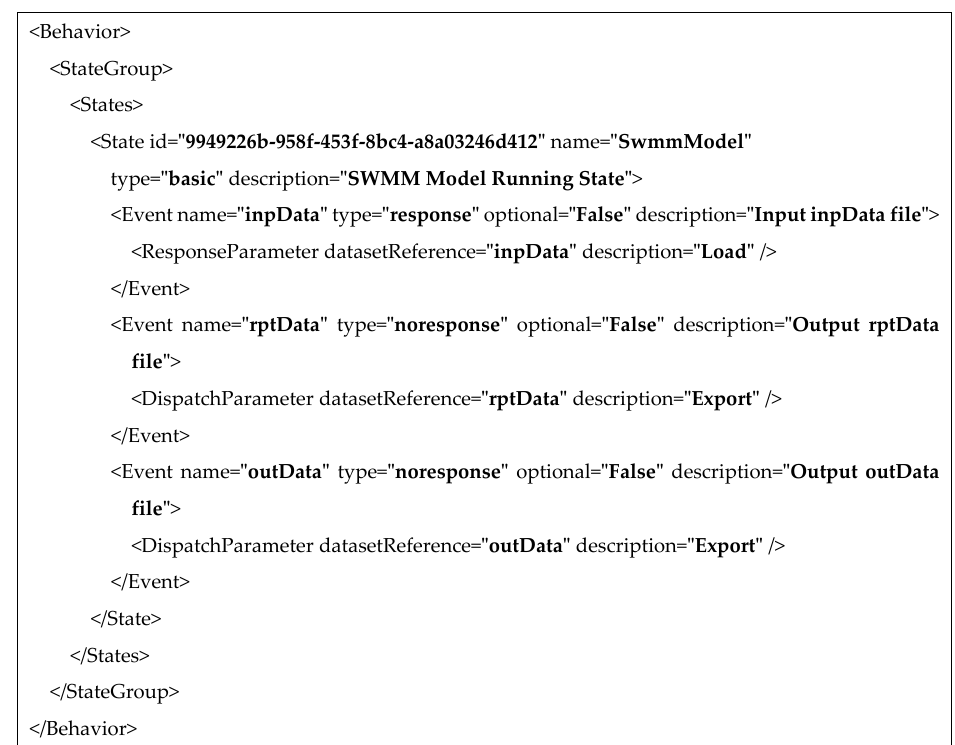
Figure 4. Description of the model execution interface in the MDL.